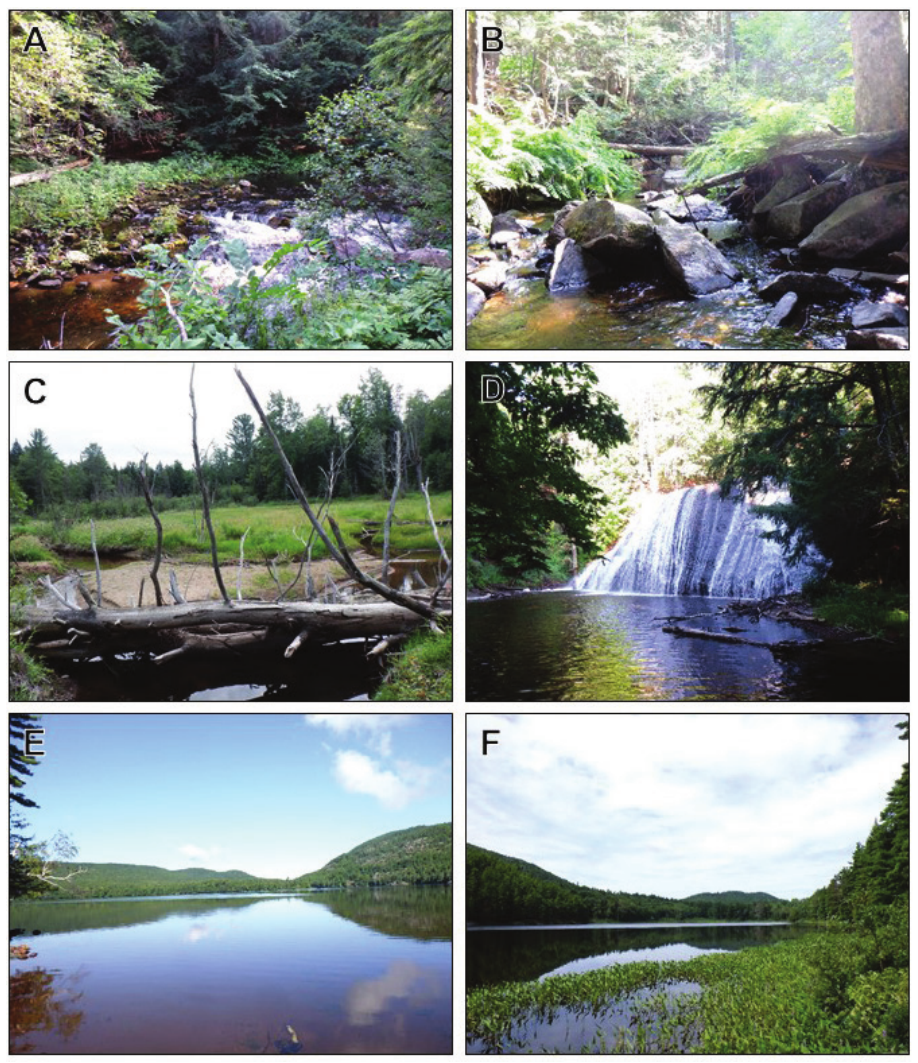
Figure 2. Representative habitats of the Huron Mountains A Middle Rapids of the Salmon Trout River (Site 17) B River Styx, below the cascade (13) C multiple braided channels of the North Fork of Elm Greek (14) D pool below the falls of Mountain Stream (10) E Mountain Lake (3) F Third Pine Lake (5). Site numbers correspond to Fig. 1 and Tables 1, 2. Photographs taken August